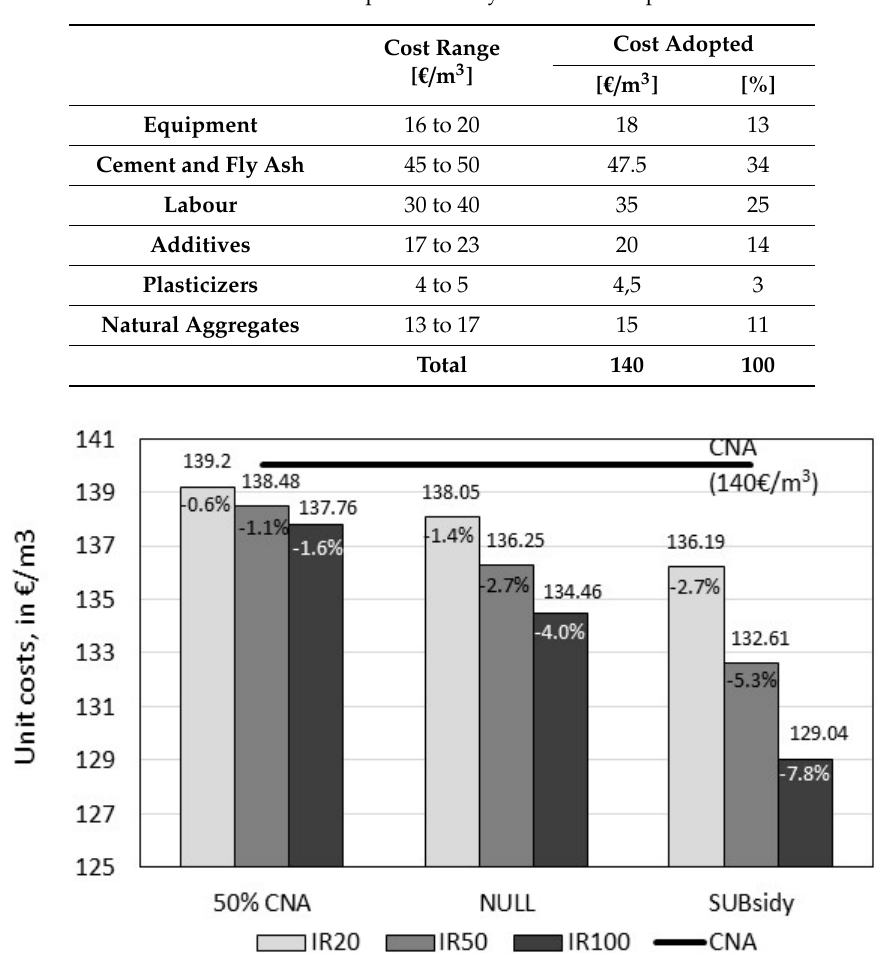
Figure 2. Cost of shotcrete for each composition, assuming different cost scenarios of the recycled